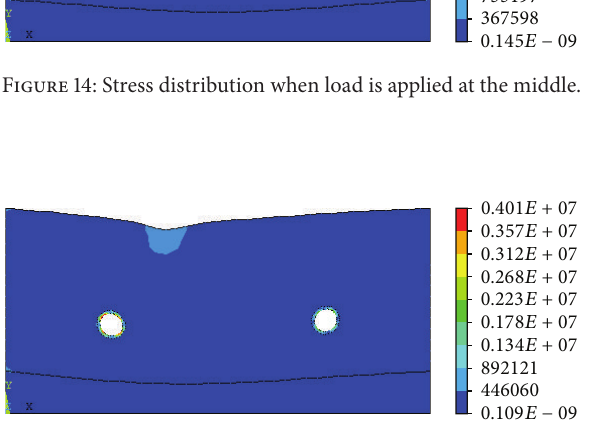
Figure 15: Stress distribution when load is applied